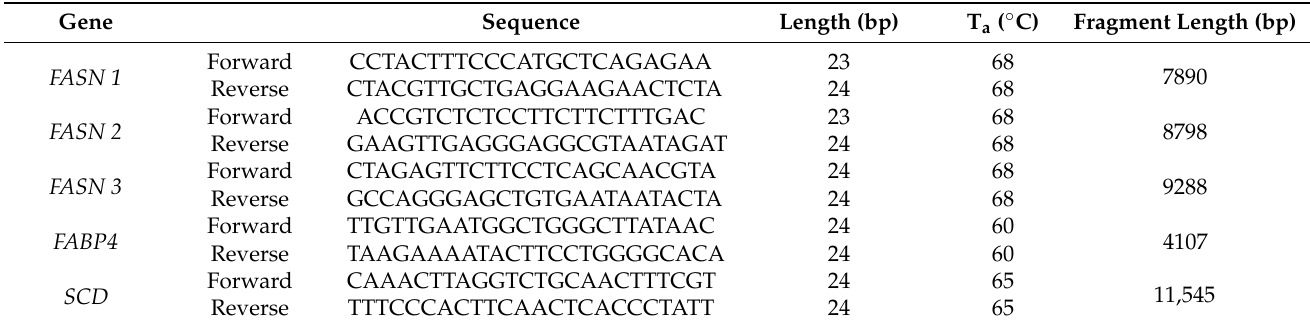
Table 1. Primer sequences for FABP4 , FASN, and SCD polymerase chain reaction assays # . Gene